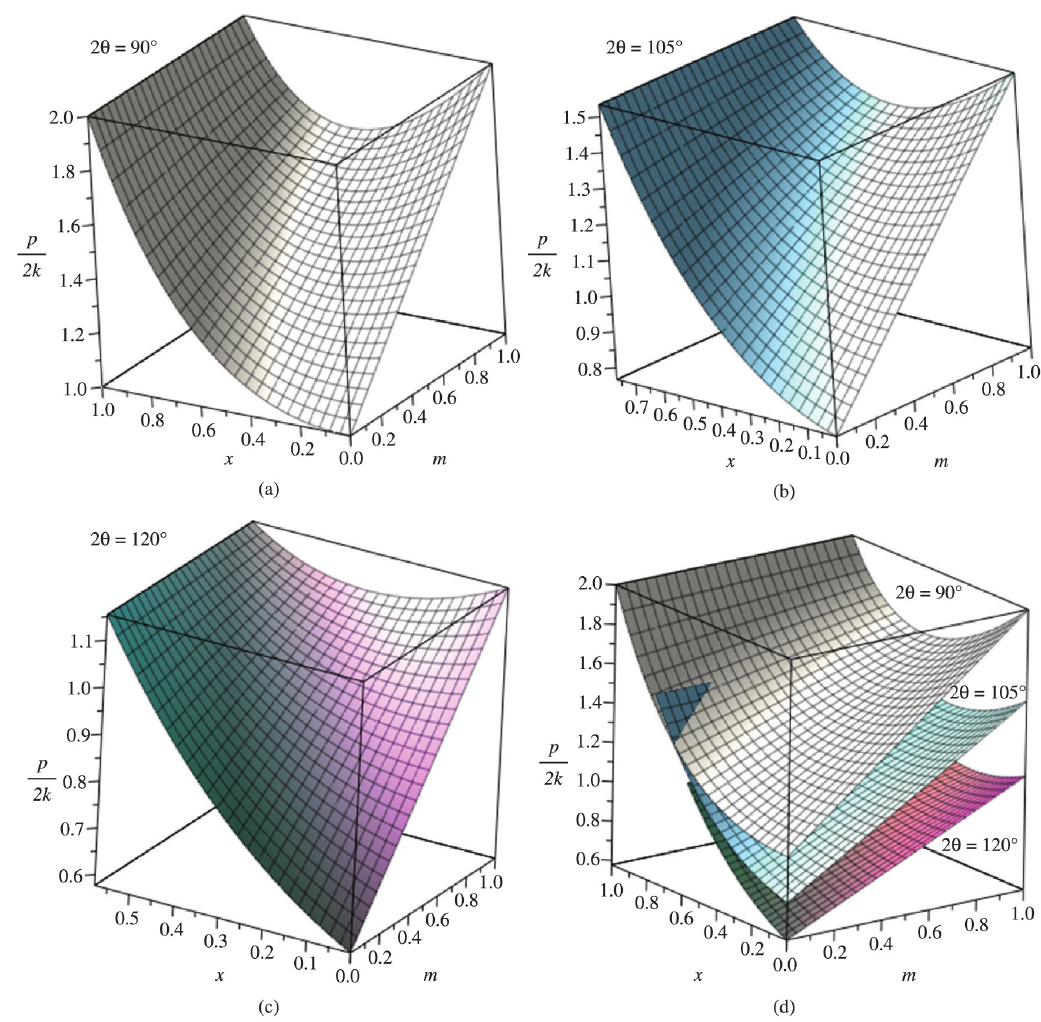
Figure 3. Spatial surface graphs ( d ) for relative ECAE punching pressure p/2k versus dead zone relative length x and friction factor m for Segal 2 θ -dies with channels intersection angles 2 θ =90° (surface of Floral White color in a , d ), 2 θ =105° (surface of Sky Blue color in b , d ), and 2 θ =120° (colored surface in c , d